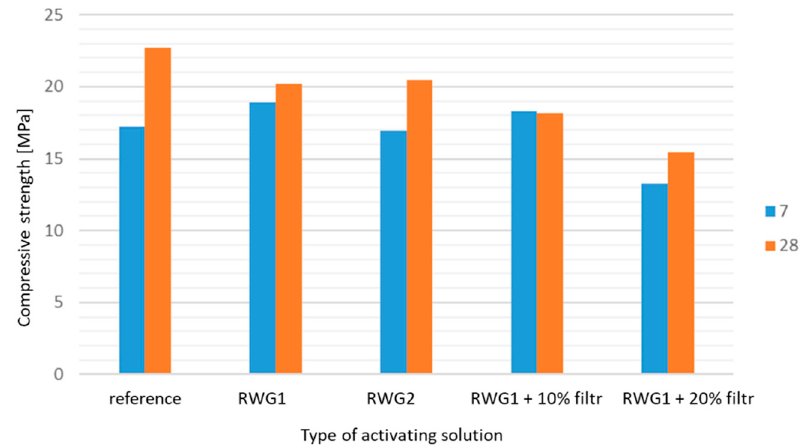
Figure 2. Compressive strength of IP synthetized with alternative activating